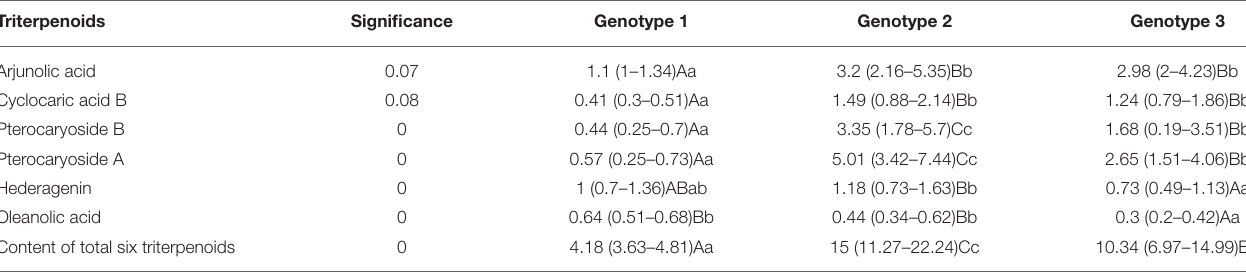
TABLE 7 | Kruskal–Wallis test and multiple comparisons between genotypes and triterpenoids of C. paliurus .